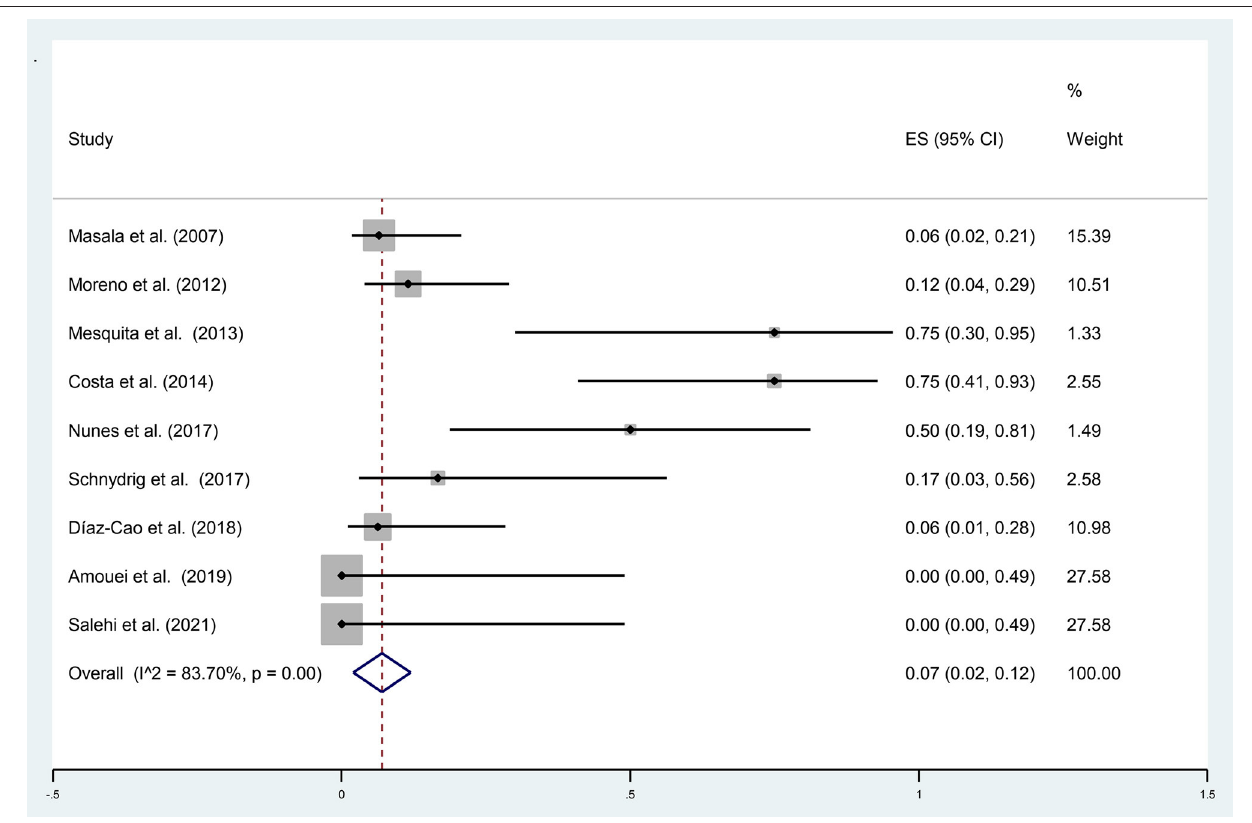
15% (95% CI: 9–21%) and 7% (95% CI: 2–12%) in the